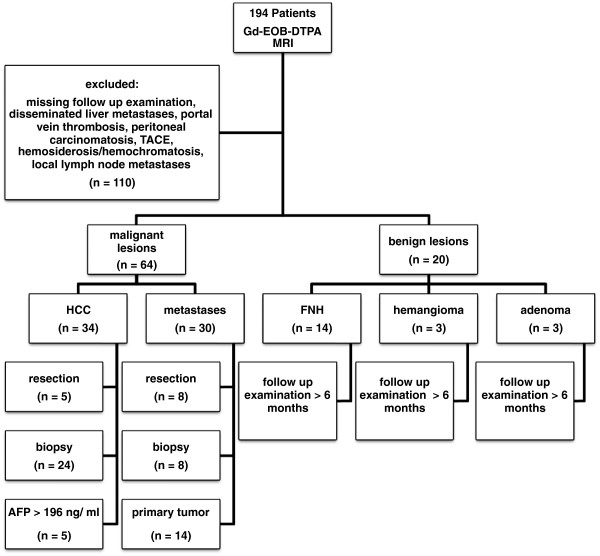
Flowchart of patients and lesions included in this trial. 194 patients underwent Gd-EOB-DTPA-enhanced MRI of the liver. 110 patients were excluded, mainly because of missing follow-up examinations, and 84 consecutive patients were included. Malignant lesions (n = 64) were proven by histology (n = 45), or diagnosis was either based on AFP > 196 ng/ml (n = 5) or knowledge of the primary tumor in case of metastases (n = 14). Benign lesions (n = 20) showed no change on follow-up examinations for more than 6 months.